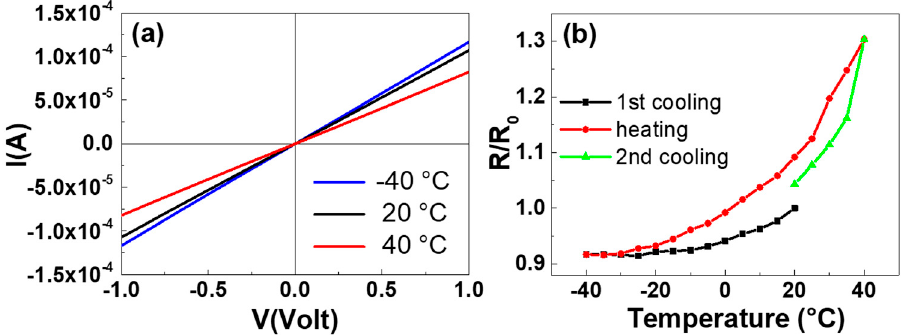
Figure 8. Current-voltage (I-V) characteristics recorded at different temperatures of a GNP film deposited on LDPE substrate ( a ). The ratio of the resistance R to the initial resistance R 0 at 20 °C (R/R 0 ) vs. temperature during a cooling-heating-cooling cycle for a GNP film deposited on LDPE substrate ( b ).